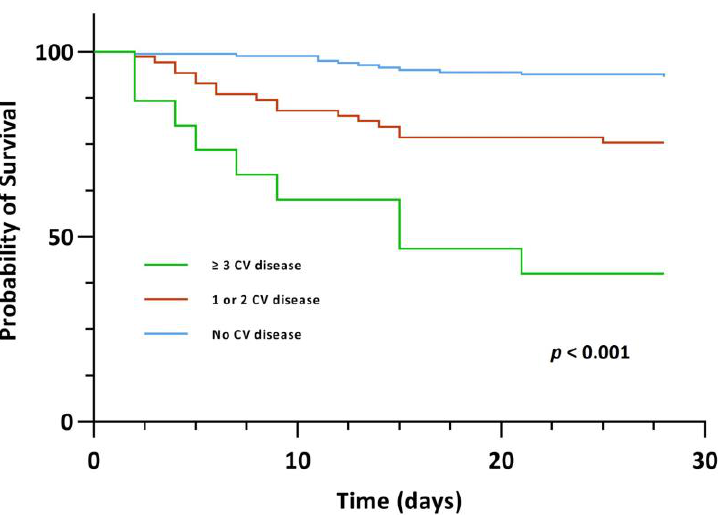
Figure 4. Kaplan-Meier survival curve for the primary endpoint of 28-day mortality stratified by CV disease.